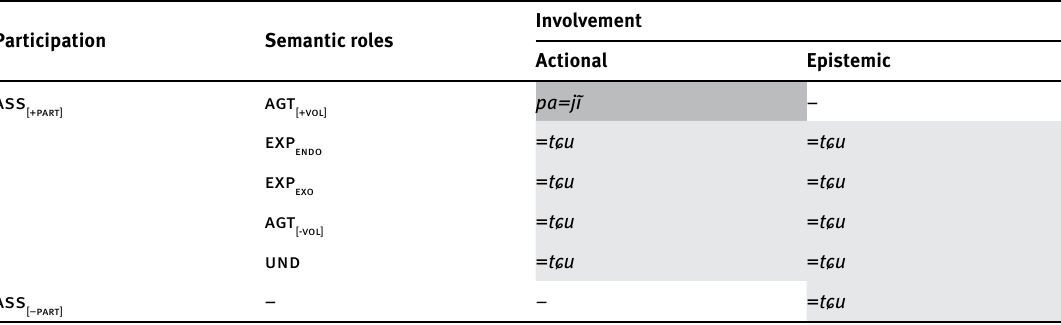
Figure 5. Modeling Shigatse Tibetan perfective egophoricity markers